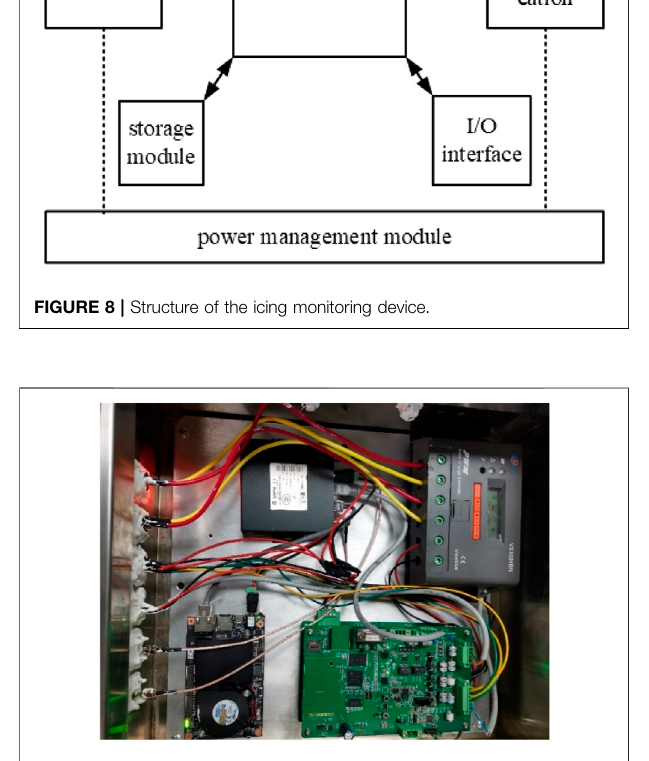
FIGURE 9 | Physical structure diagram of icing monitoring